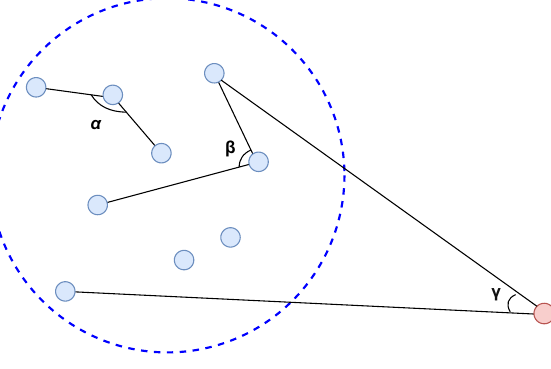
Figure 8. An illustration of